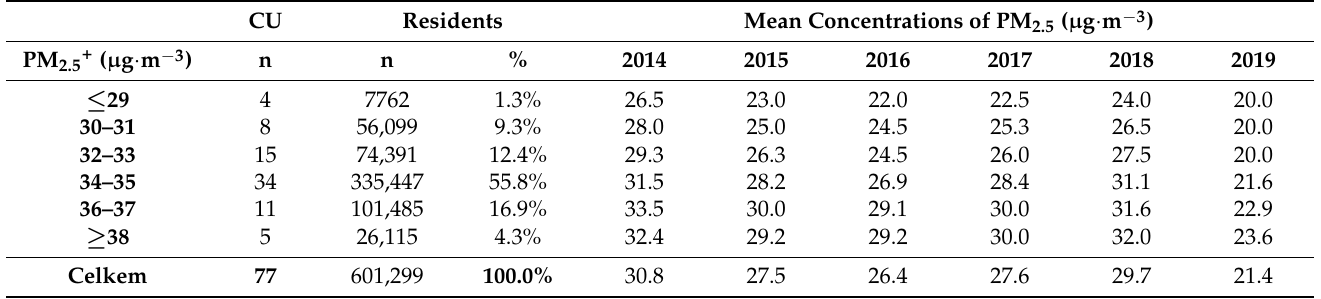
Table 1. Cadastral units in the Ostrava and Karvina districts classified into concentration intervals according to PM 2.5 (development of the mean concentrations during the monitored years since